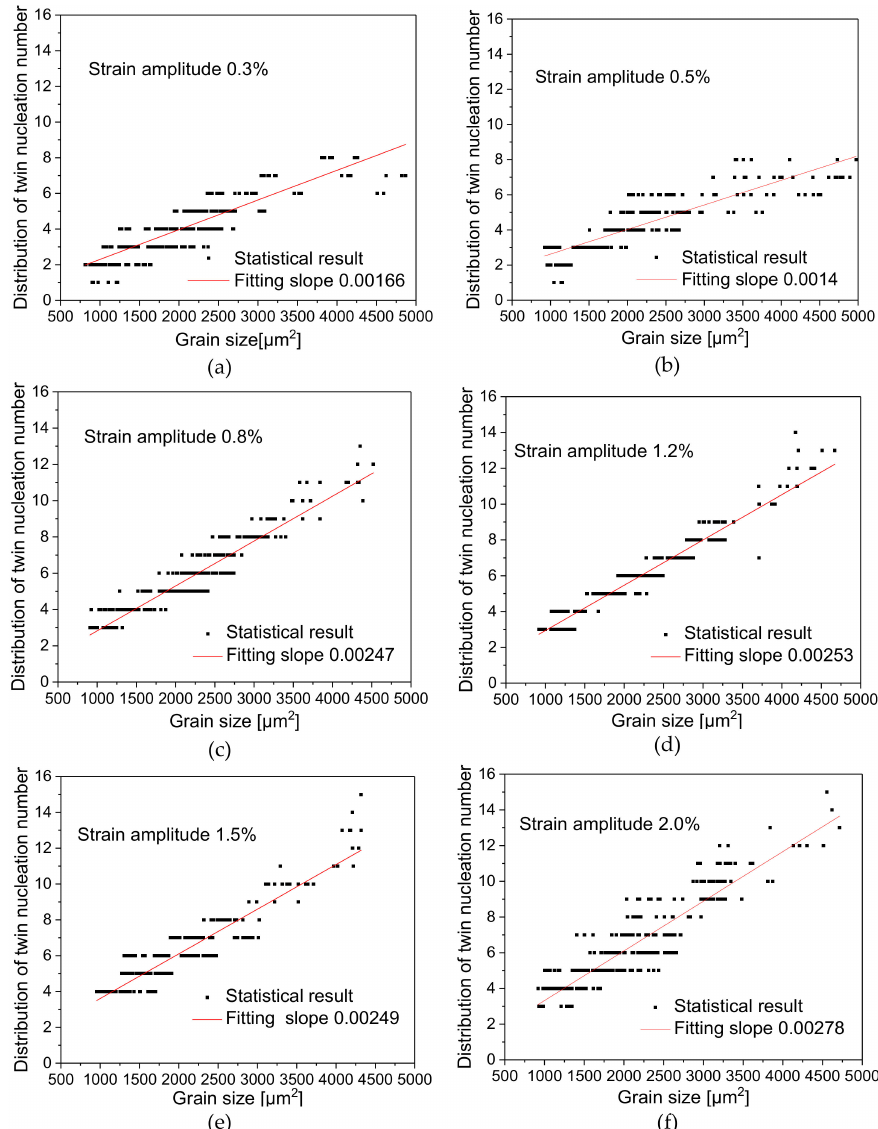
Figure 7. Distribution diagram of the relationship between grain area size and TNN at di ff erent strain amplitudes:( a ) 0.3%; ( b ) 0.5%; ( c ) 0.8%; ( d ) 1.2%; ( e ) 1.5%; ( f )